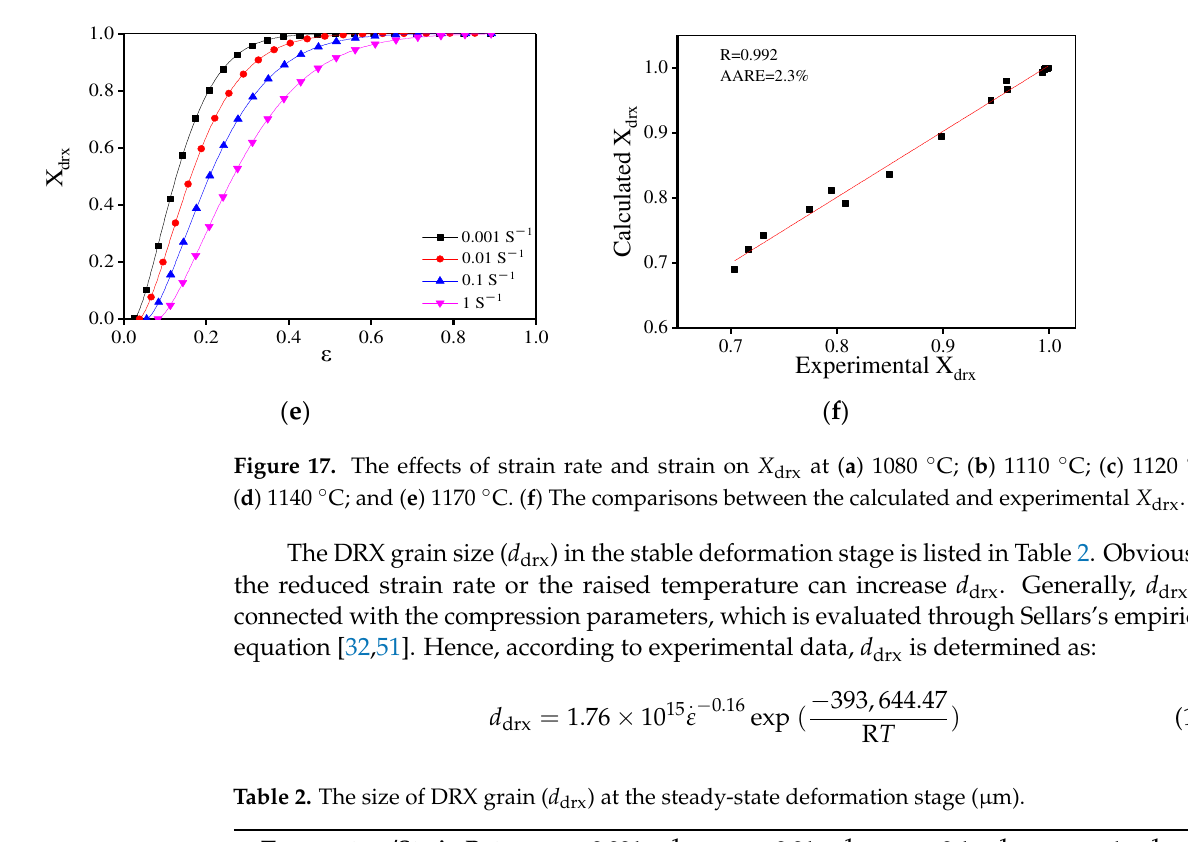
Table 2. The size of DRX grain ( d drx ) at the steady-state deformation stage ( µ m). Temperature/Strain Rate